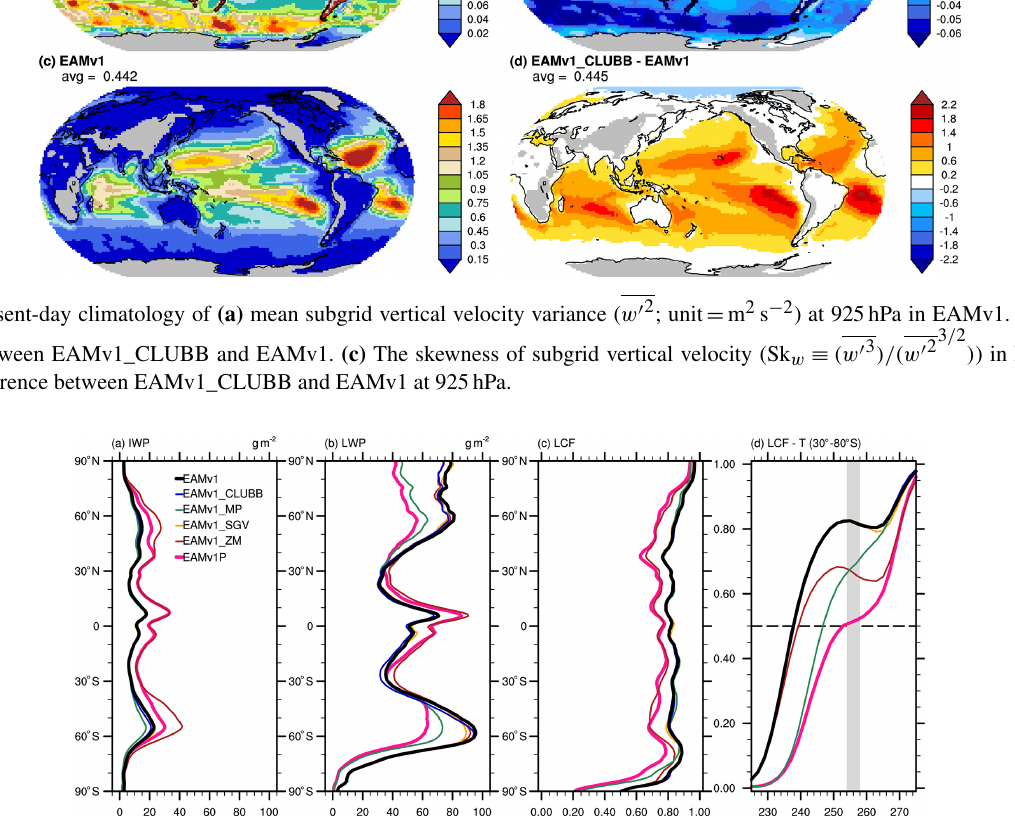
Figure 3. Zonal mean of (a) ice water path (IWP), (b) liquid water path (LWP), and (c) liquid condensate fraction (LCF), defined as the ratio of liquid to total cloud condensate amount, and (d) LCF as a function of temperature (unit = K) between 30 and 80 ◦ S. The horizontal dashed line in (d) denotes T5050 (McCoy et al., 2016, 2015), where ice and liquid each contributes to 50% of the total condensate. The observational estimate of T5050 range (McCoy et al., 2016) are shown in the gray-shaded area.